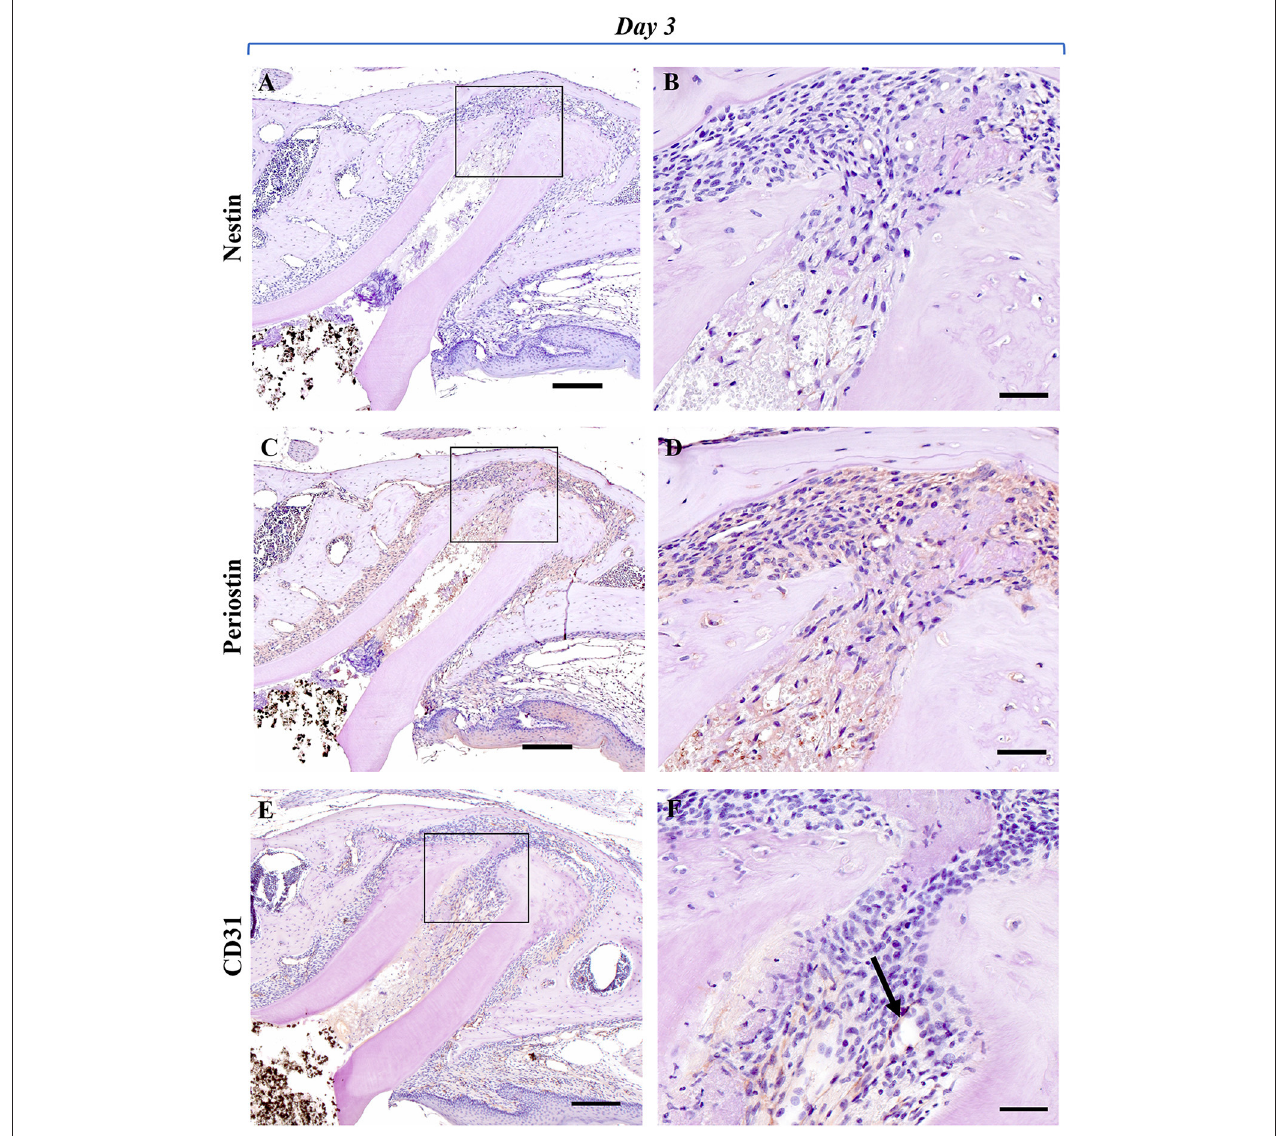
FIGURE 2 | Representative IHC-stained images of the experimental group at 3 days. Nestin: (A,B) ; Periostin: (C,D) ; CD31: (E,F) . (A) No nestin-positive cells were observed in the mesial root canal or around the apex. (B) Higher magnification of the black box area in (A) . No cells showing a nestin-positive reaction were found around the fibroblast-like cells growing from the apex. (C) Localization of periostin-positive cells was markedly observed in the mesial root canal and the PDL area around the apex. (D) Higher magnification of the black box area in (C) . Periostin-positive cells were observed around the spindle-shaped fibroblast-like cells growing in the root canal from the periapical tissue. (E) Positive cells showing immunoreactivity to CD31 were markedly observed in the PDL region around the mesial root, and directly under the gingival epithelium. (F) Higher magnification of the black box area in (E) . Spindle-shaped vascular endothelial cells showing immunoreactivity to CD31 (black arrow) were observed near the apex of the root canal (Scale bars = 200 µ m in A, C, E; scale bars = 50 µ m in B, D,